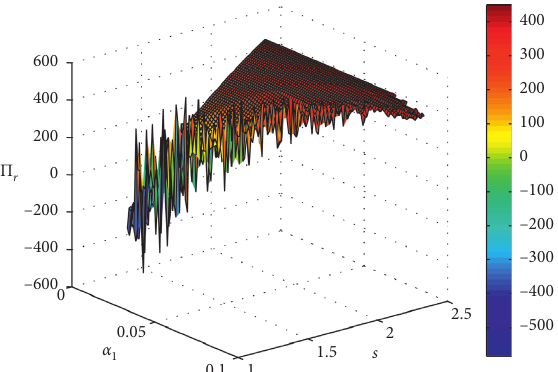
Figure 18: 3D profit diagram for the retailer with α